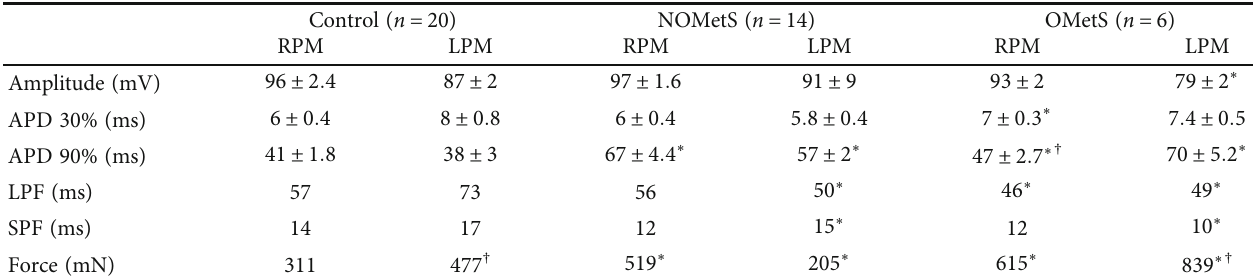
Table 3: Electrical and mechanical ventricular